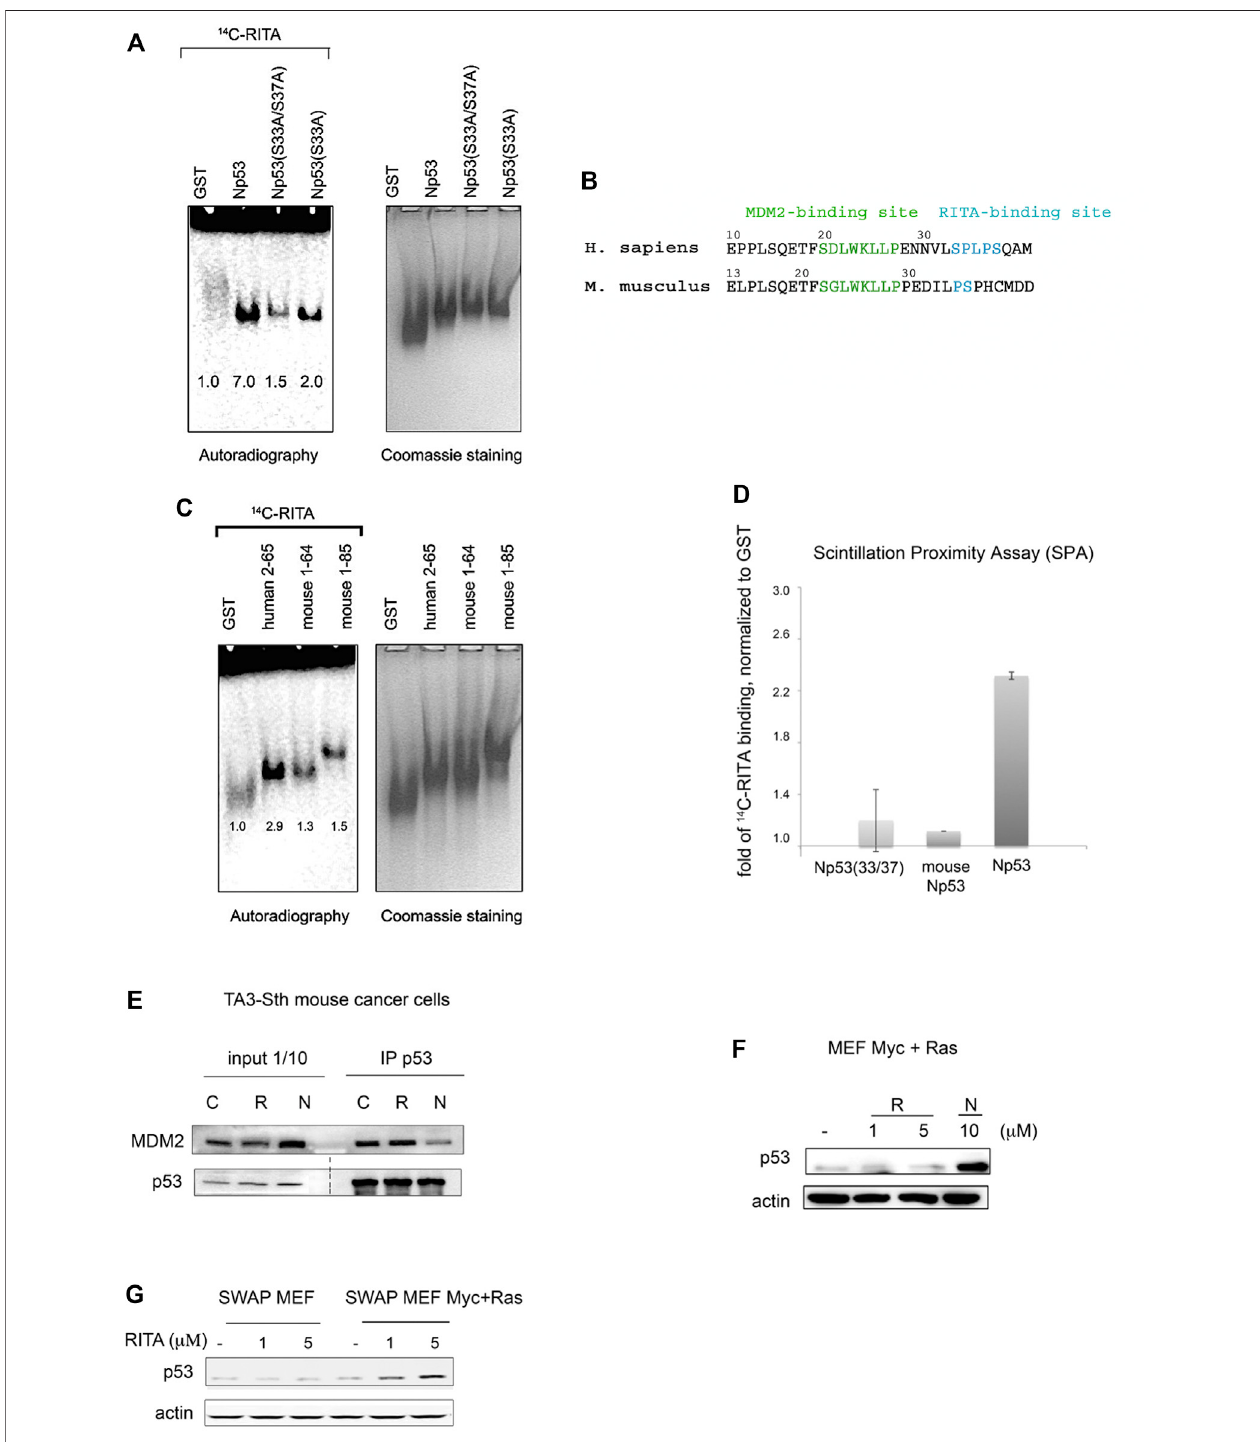
FIGURE5| Serine33andserine37arecrucialforthebindingofRITAtothep53 N-terminus. (A) Assessmentof[ 14 C]-RITAinteractionwithNp53proteinscarrying alanine substitutions of S33 or S33/S37 using band shift assay (8% TBE). Np53(S33/S37) binding to [ 14 C]-RITA in vitro is negligible. Bands ’ densities were quanti fi ed using ImageJ software and normalized to GST-tag. (B) Alignment of murine and human p53 N-termini. Highlighted are the sites for MDM2 interaction and the RITA- bindingmotif. (C,D) RITAdoesnotbindtomouseNp53proteins,spanningresidues1 – 64and1 – 85asdetectedbybandshiftassayin8%TBEgelandscintillation proximity assay (SPA). Np53(33/37) was used as a negative binding control in SPA assay. (E) Co-immunoprecipitation showed that RITA does not prevent p53/MDM2 interaction in TA3-Sth mouse cancer cells. C — control untreated sample, R — RITA-treated, N — nutlin-treated samples; dotted line represents different exposure time of thispartofthemembrane. (F) .Mousep53inMyc-andRas-transformedmouseembryonic fi broblasts(MEFs)isnotinducedbyRITA(R)incontrasttonutlin(N). (G) .RITA induces human p53 in SWAP MEF ’ s transfected with Ras and c-Myc as detected by western blot.